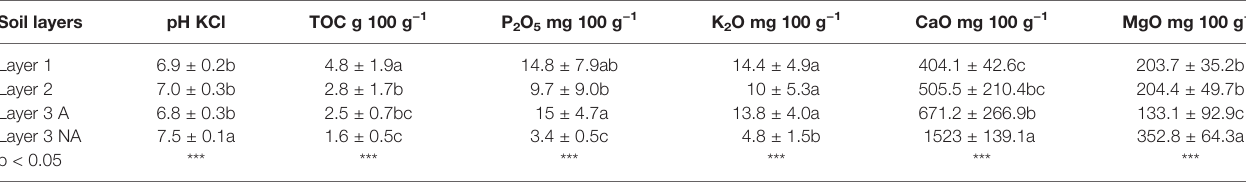
TABLE 2 | Extractible macronutrients of soil layers at the amended holes in the tailings dam (with acetate EDTA, n = 10, unit: mg 100 g − 1 of soil). Soil